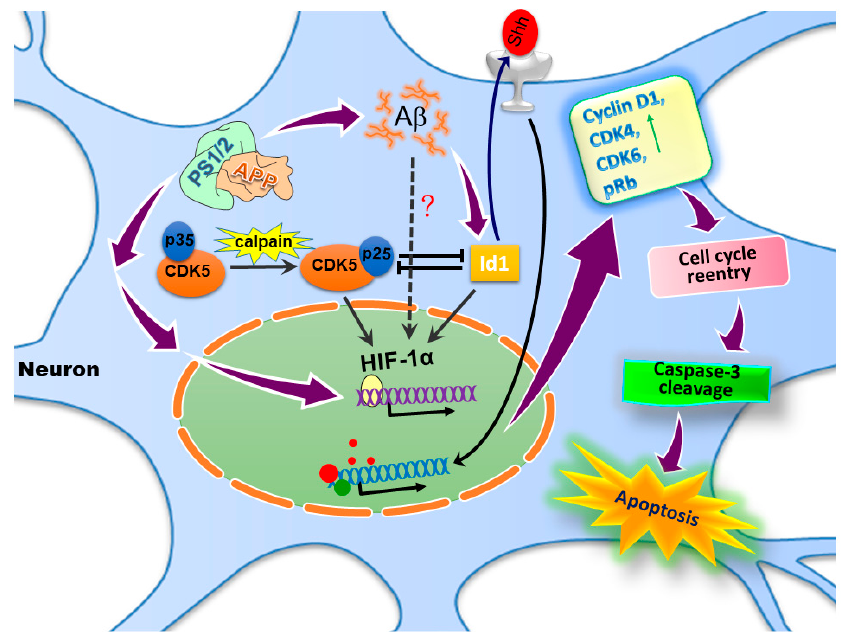
Figure 2. The schematic diagram describes the possible mechanisms of amyloid-beta peptide (A β )- and the inhibitor of DNA-binding/differentiation (Id)-1-induced neuronal cell cycle reentry and cell death. The hyperactivity of presenilin (PSEN)-1/2 (PS1/2) and γ -secretase produces abundant A β s that increase the Id1 expression, which enhances the activation of hypoxia-inducible factor-1 α